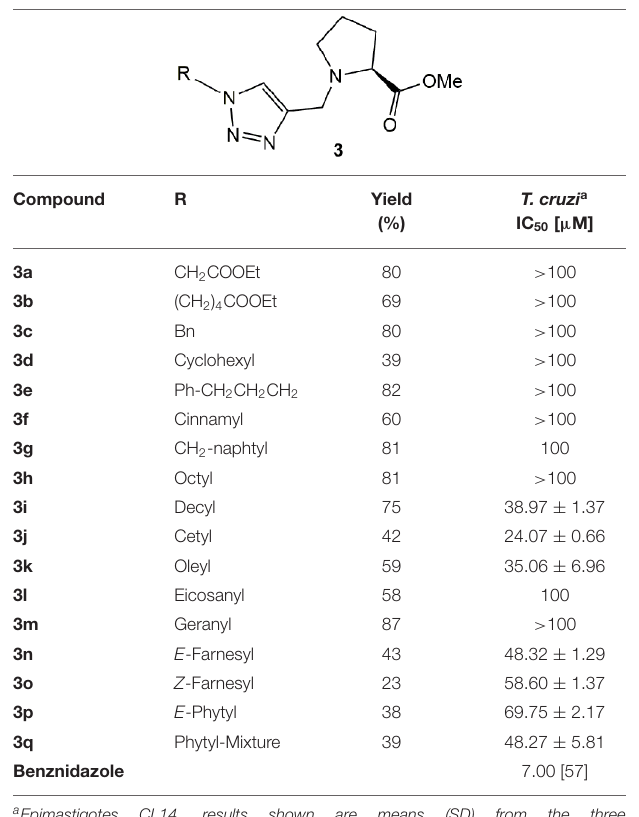
TABLE 1 | Anti- T. cruzi activity of the proline derivatives.